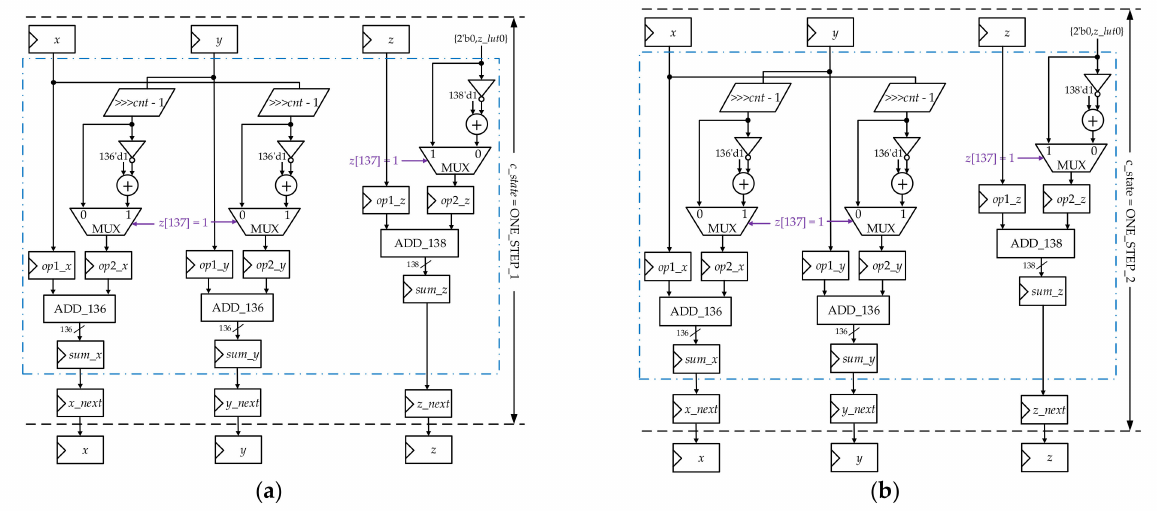
Figure 8. ( a ) Architecture of state ONE_STEP_1; ( b ) architecture of state